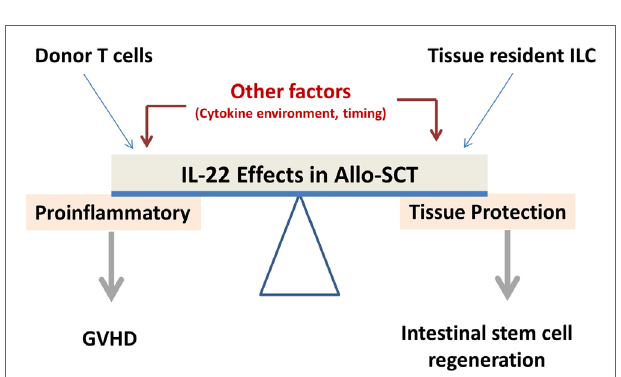
FiGURe 3 | Balance between inflammatory and protective effect of iL-22 .